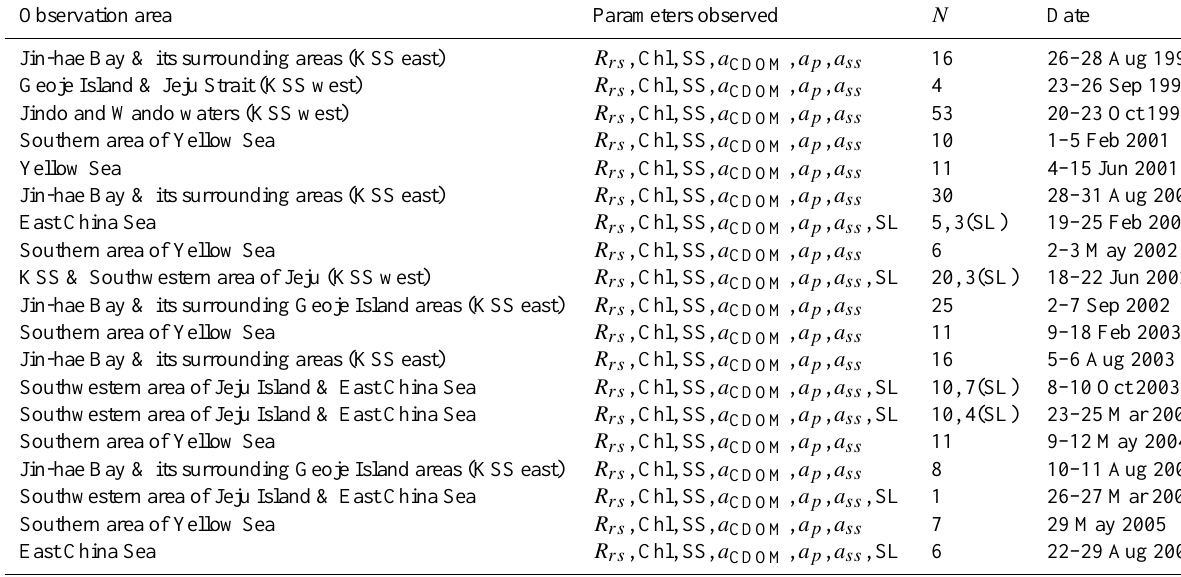
Table 1. Information regarding the in-situ data. N – number of observations, and SL – salinity. Observation